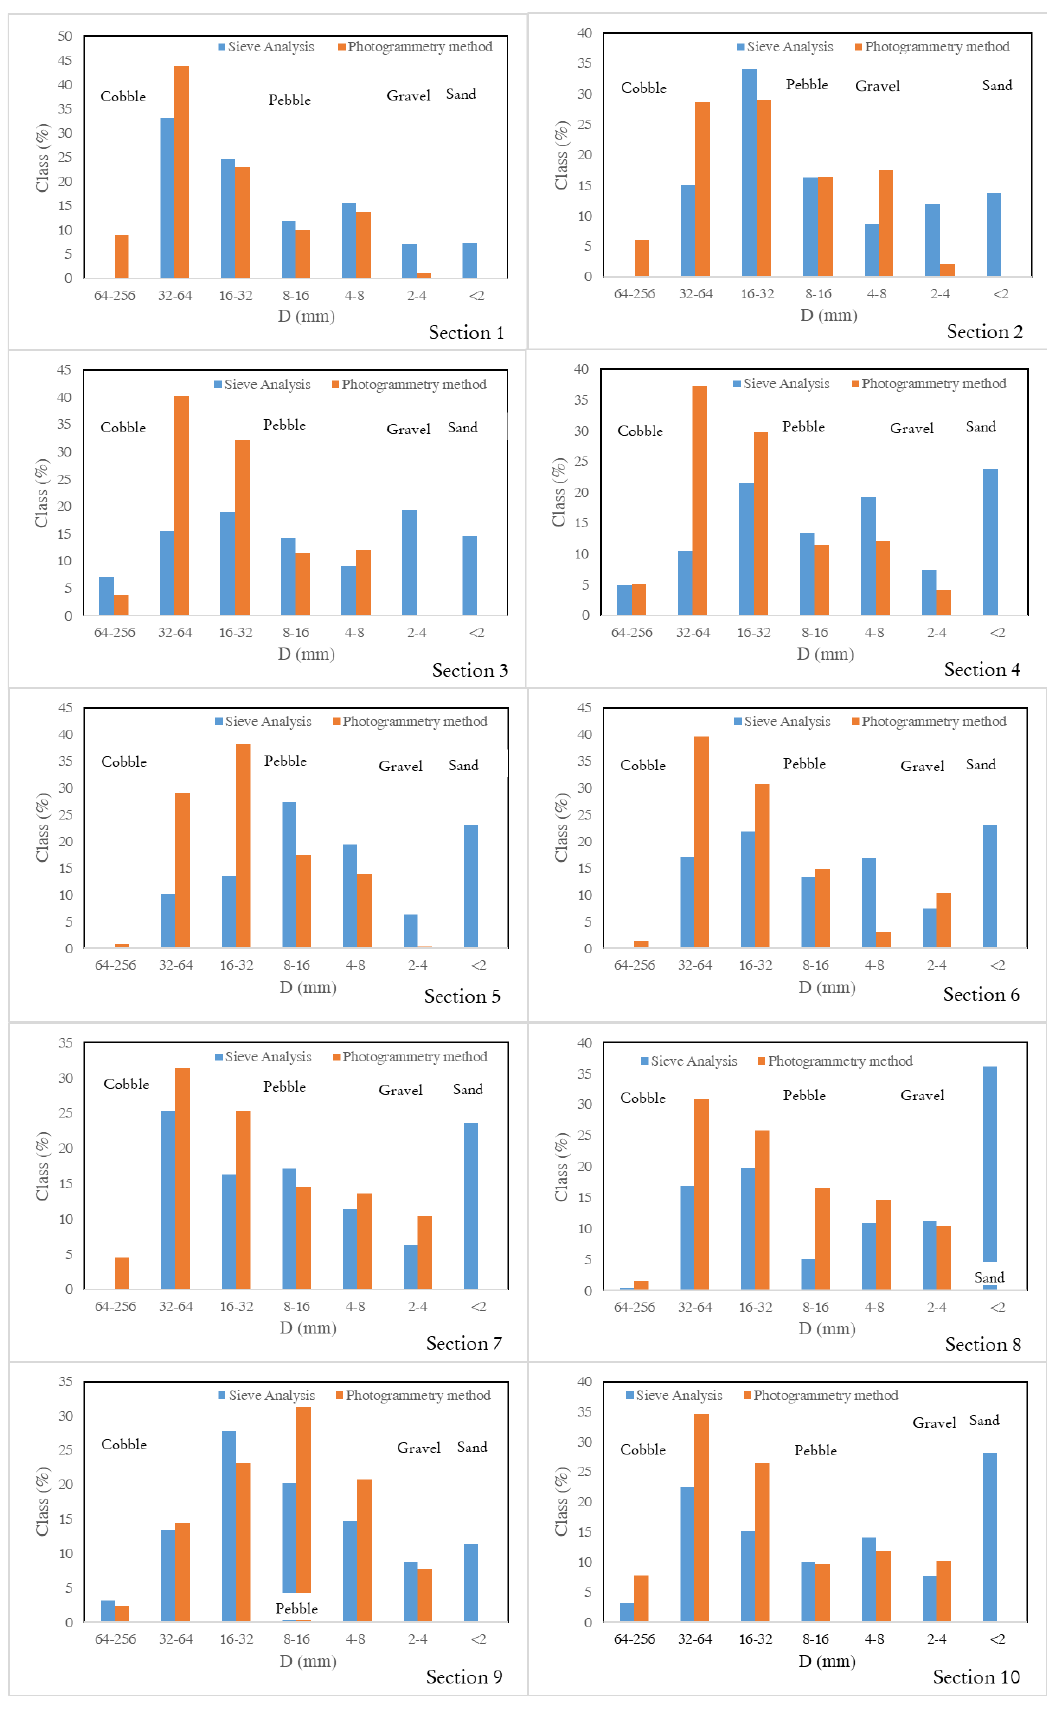
Figure 7. Bar charts of the photogrammetry method and sieve analysis at each cross section.